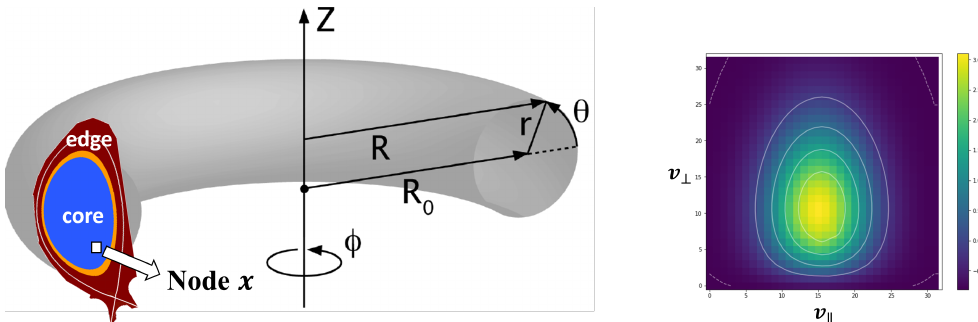
Figure 1. Coordinates of the XGC dataset ( left ) and an example particle distribution histogram ( right ). The XGC simulates a massively large number of particles in a 5D physics space and regularly calculates particles distributions at each discretized node. This is one of the large datasets in